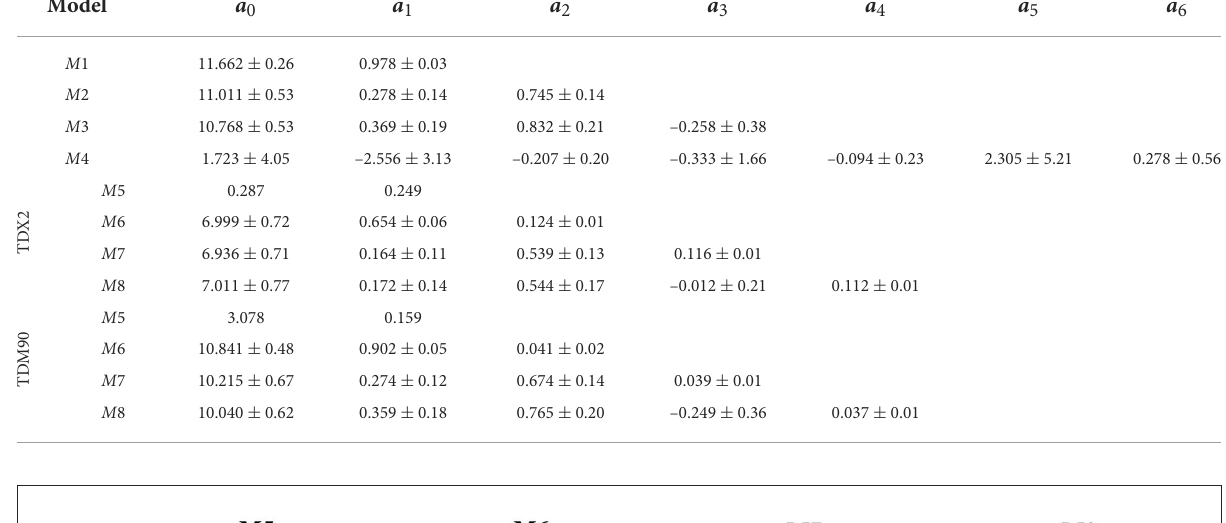
TABLE 5 Mean and standard deviation of model coefficients for the eight models evaluated across multiple dates for TDX2 height and TDM90m height inputs. Model